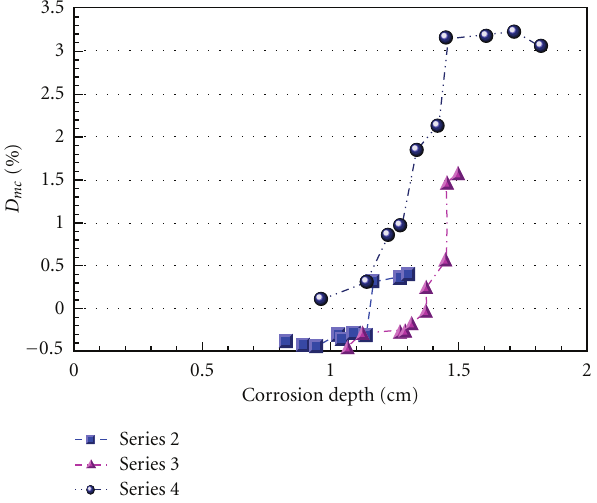
Figure 10: Relation between corrosion depth and compressive strength of corroded concrete.